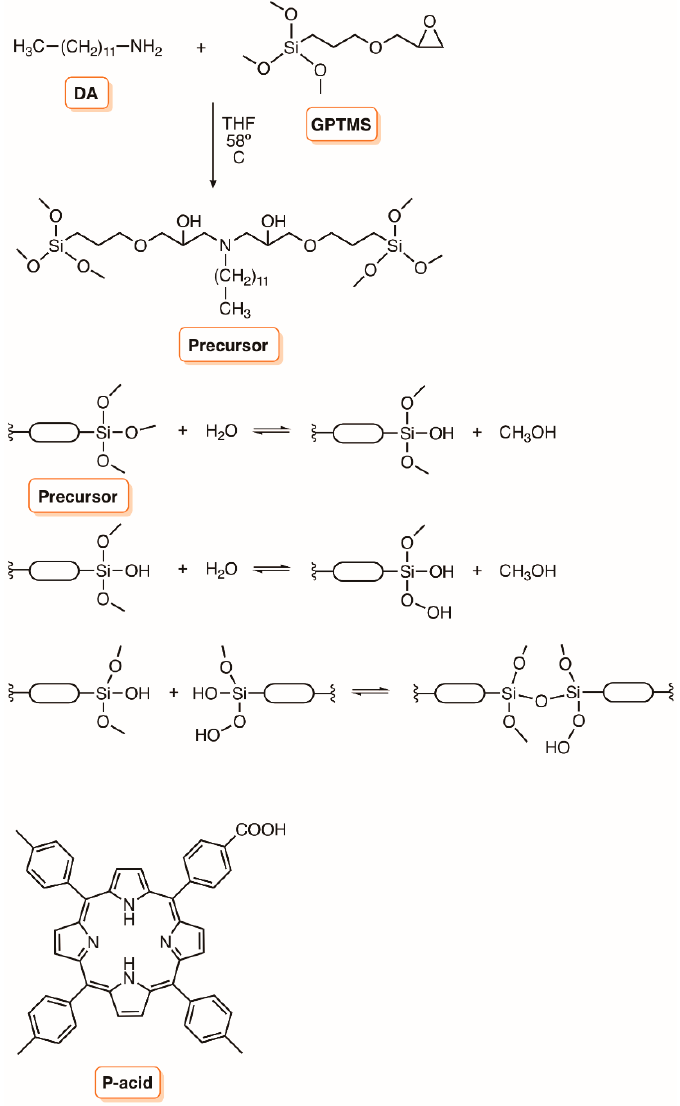
Figure 16. Preparation of the polysilsesquioxane flexible films doped with 5-(4-carboxyphenyl)- 10,15,20-tris(4-methylphenyl)porphyrin (adapted from Reference [105]).